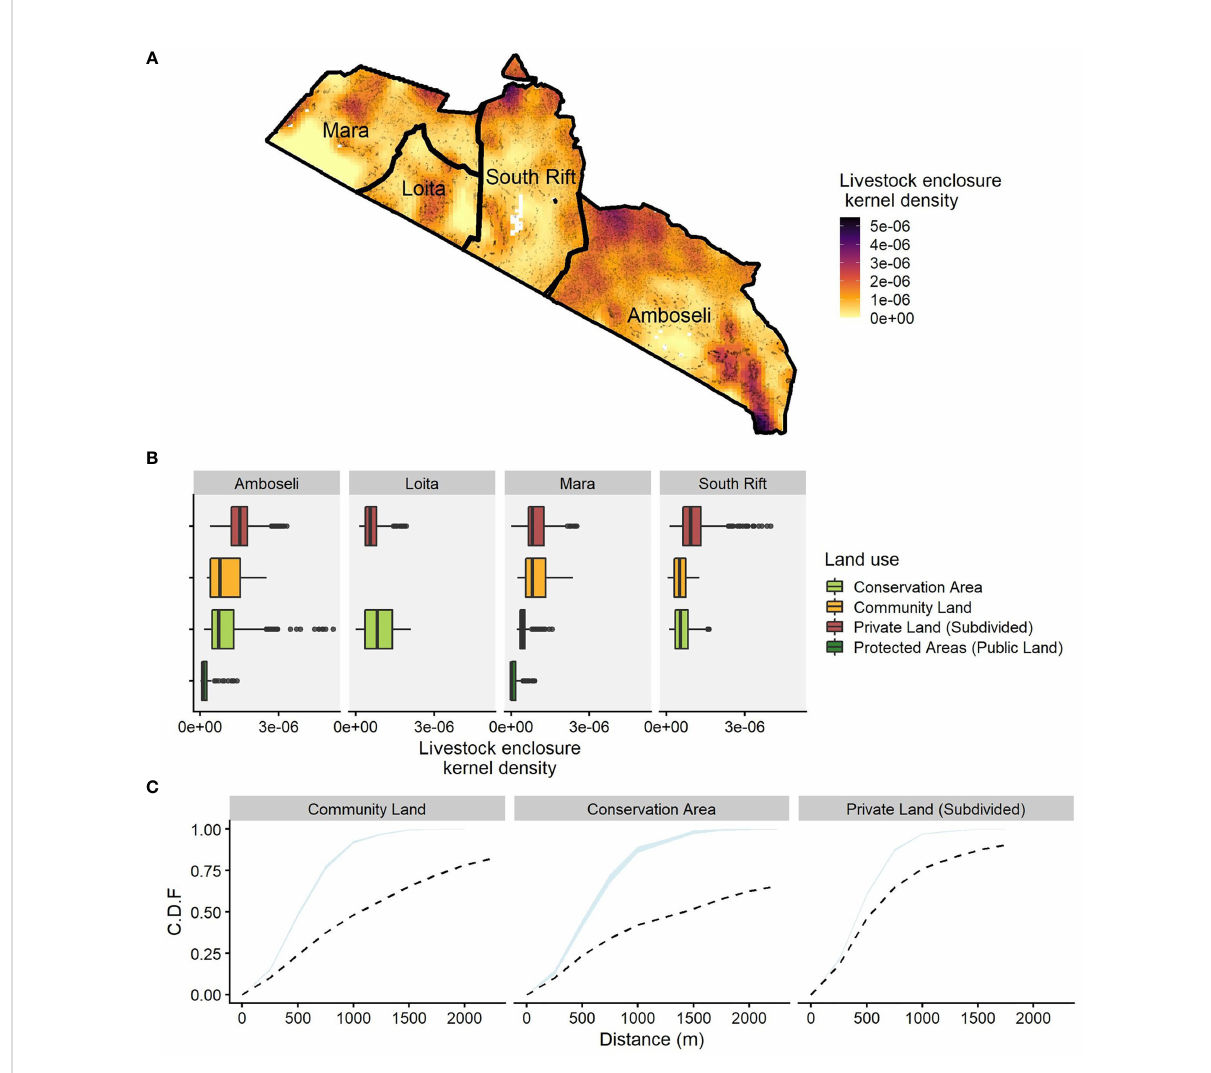
FIGURE 4 In southern Kenya, space for wildlife and livestock is limited in private, subdivided land. Here, livestock enclosures are at higher densities and less space exists between them than in community land or conservation areas. (A) Livestock enclosure kernel density calculated using 29,467 georeferenced locations (black dots); (B) boxplots showing different livestock enclosure kernel density values for the four ecosystems and four land tenure types; (C) the cumulative distribution function (CDF) of the distance from a fi xed point in space to the nearest (and successively next) livestock enclosure, calculated using the empty space function F of a stationary point process for each land tenure type. Protected areas are excluded because they have few or no settlements within their boundaries. The blue ribbon represents the 96% point-wise intervals of the theoretical distribution of livestock enclosures under a stationary Poisson process of the same estimated intensity. Conservation areas have the shallowest slope, indicating the greatest distances between livestock enclosures, whereas the curve for private subdivided land increases steeply to an asymptote, indicating that little open space is